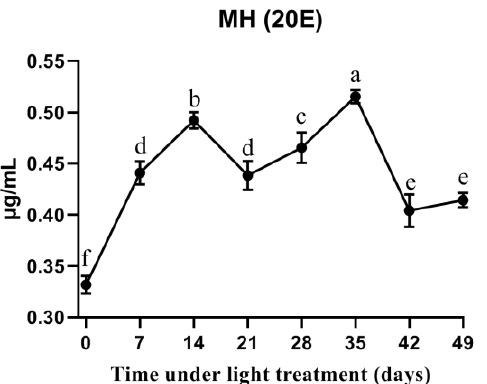
Figure 7. Ecdysteroid (20E) titer changes in pupal hemolymph from diapause to eclosion under the long photoperiod (17 h L:7 h D).